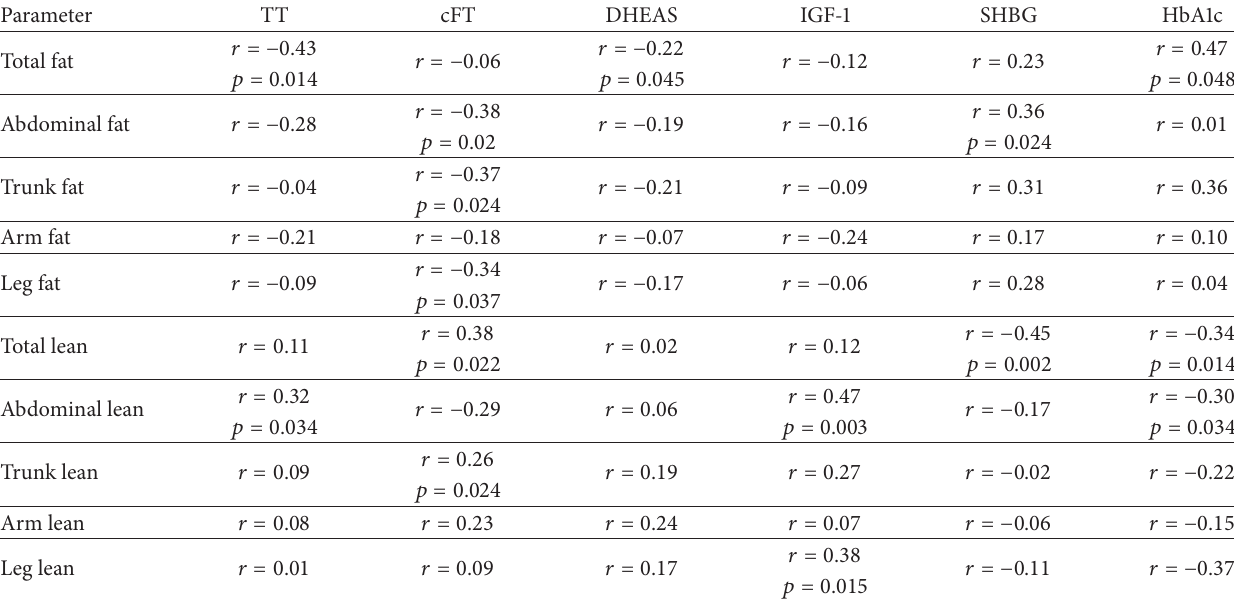
Table 4: Pearson’s coefficients (age- and BMI-adjusted) for correlations between body composition parameters, anabolic hormones levels, SHBG, and HbA1c in patients with PD (no.